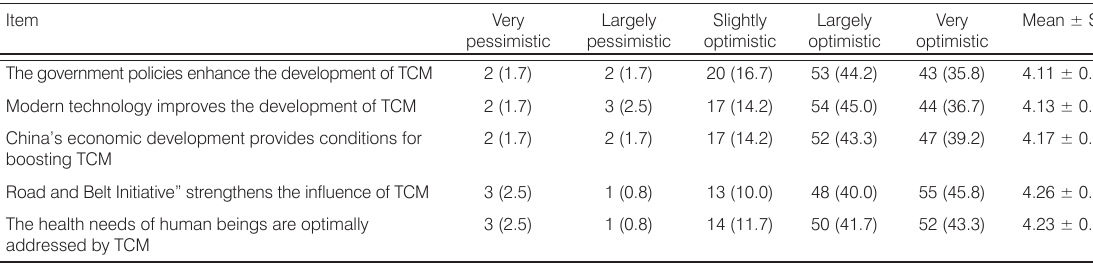
Table 6. Attitudes toward the future of TCM ( n , %).